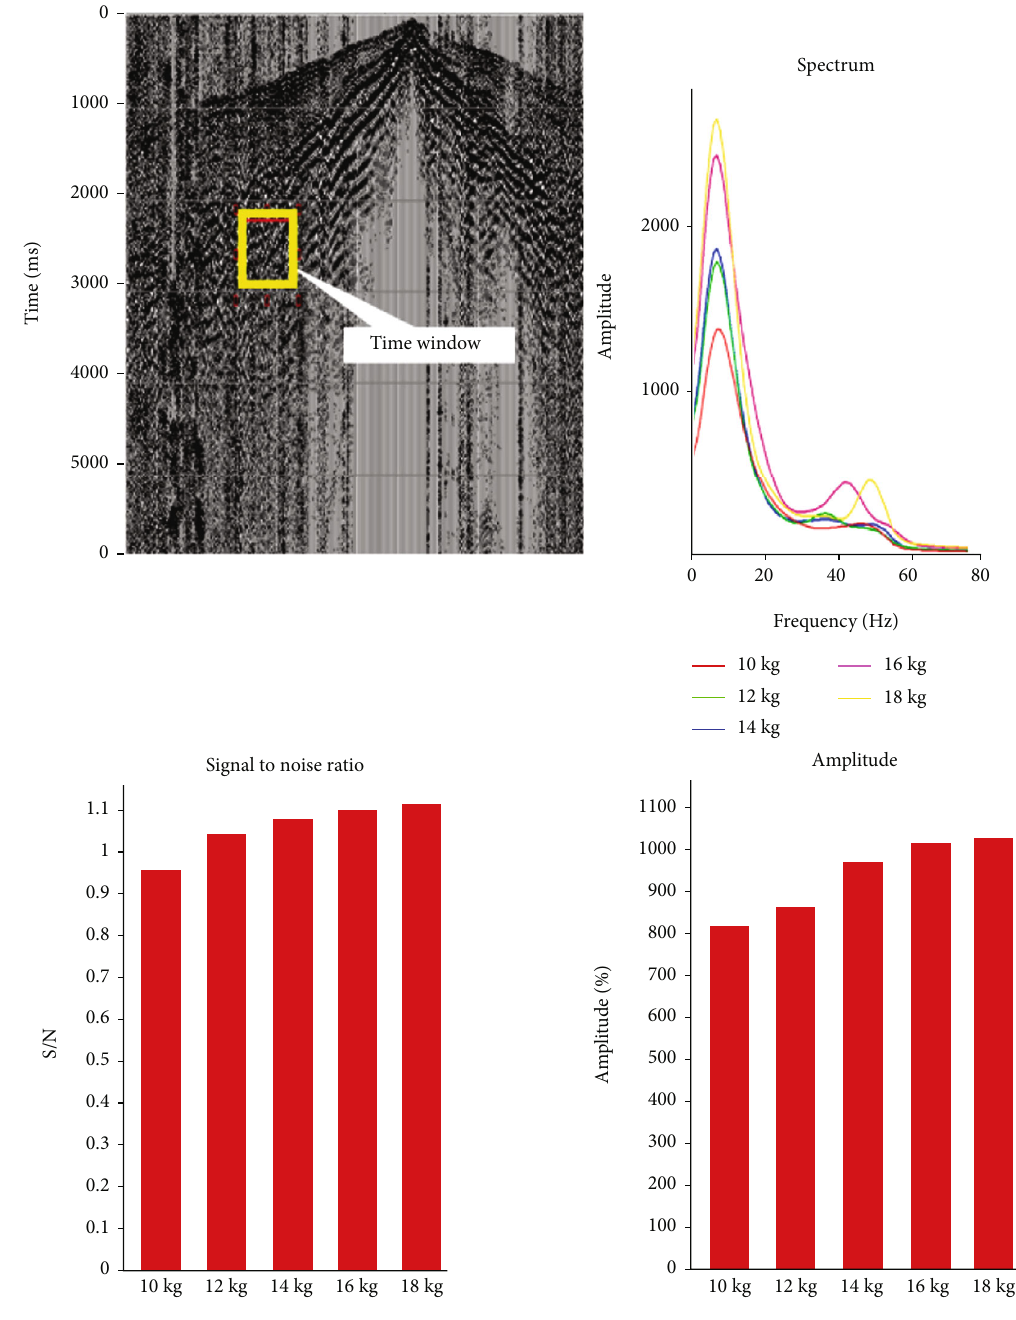
Figure 4: Quantitative analysis of charge